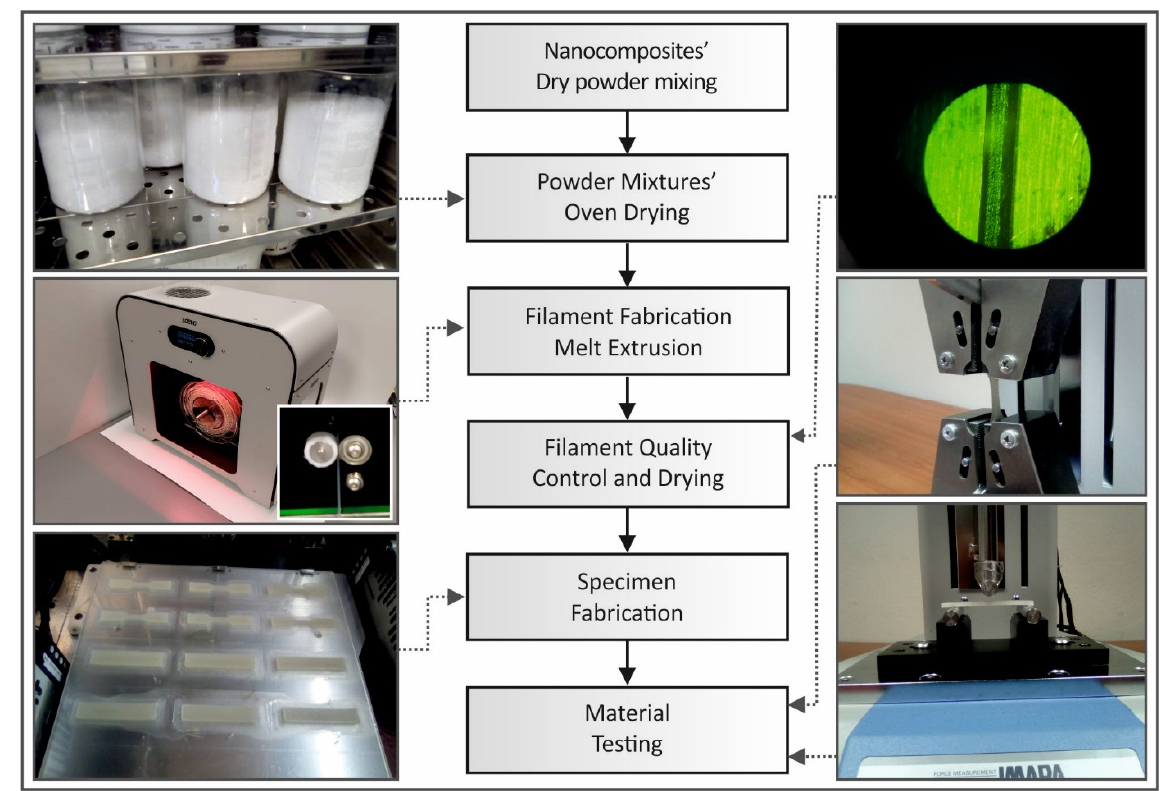
Figure 1. Schematic illustration and photos captured during the processes followed in this study. Filament fabrication of diameter suitable for 3D printing (1.75 mm) followed, using